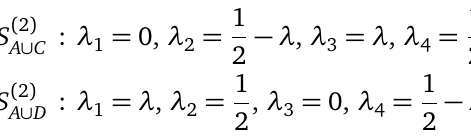
Figure 4: We show the large- N result for I / N = 0.1 (blue triangles), 0.2 (red squares), and 0.3 (green circles), with λ : = N A where N and N are the numbers of fermions in A and in the full system, respectively. A The solid gray lines indicate the minimum possible value of I of λ and are clearly saturated at late